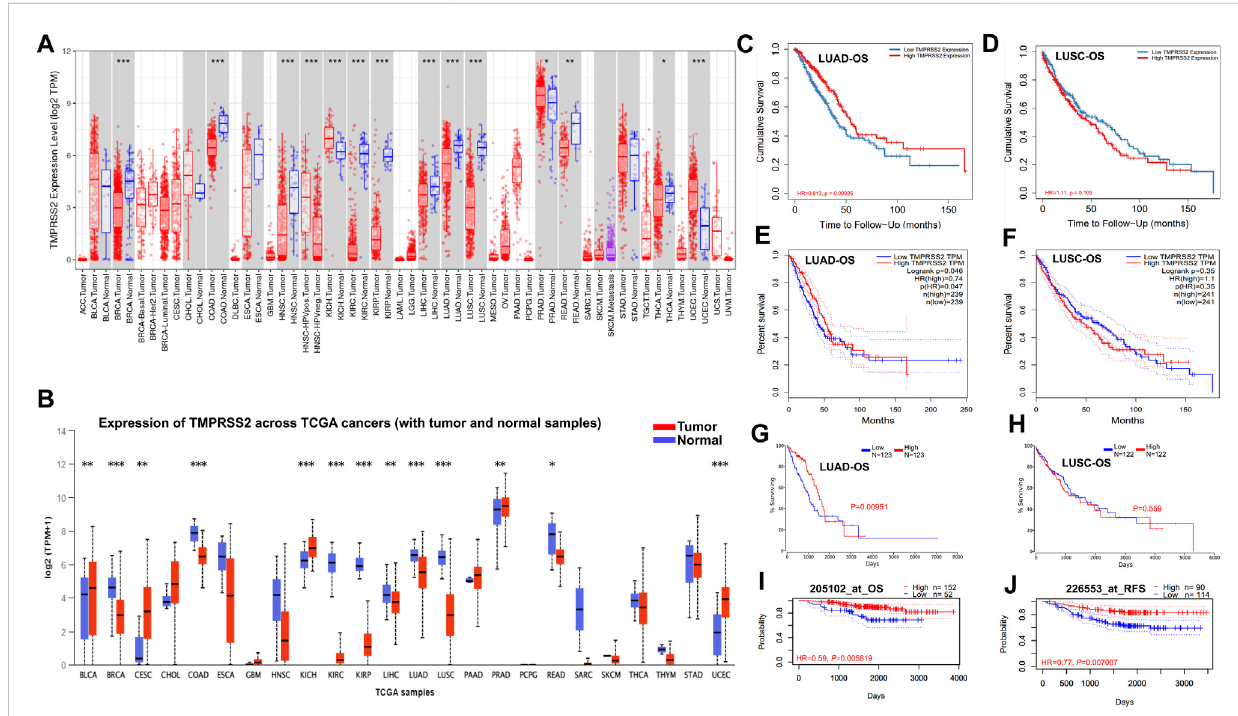
FIGURE 1 TMPRSS2 mRNA expression in different cancers and prognostic potential of TMPRSS2 in LUAD and LUSC.TMPRSS2 expression pro fi le in different cancers via TIMER2.0 (A) . Blue and red dashed lines indicate the average value of normal and tumor tissues respectively. p -value Signi fi cant Codes: 0 ≤ *** < 0.001 ≤ ** < 0.01 ≤ * < 0.05 ≤ . < 0.1.Thethresholdwassetasfollows: p -valueof1E-6,foldchangeof2,andgenerankingtop5%.TMPRSS2expression pro fi le in different cancers via UALCAN (B) . Blue and red dashed lines indicate normal and tumor tissues respectively; p -value Signi fi cant Codes: 0 ≤ *** < 0.001 ≤ ** < 0.01 ≤ * < 0.05 ≤ . < 0.1. Overall survival curves comparing the high and low expression of TMPRSS2 in LUAD (C) and LUSC (D) in the TIMER2.0. Overall survival curves comparing the high and low expression of TMPRSS2 in LUAD (E) and LUSC (F) in the GEPIA2. Overall survival curves comparing the high and low expression of TMPRSS2 in LUAD (G) and LUSC (H) in the Oncolnc database. OS (I) and RFS (J) comparing the high and low expression of TMPRSS2 in LUAD in the PrognoScan